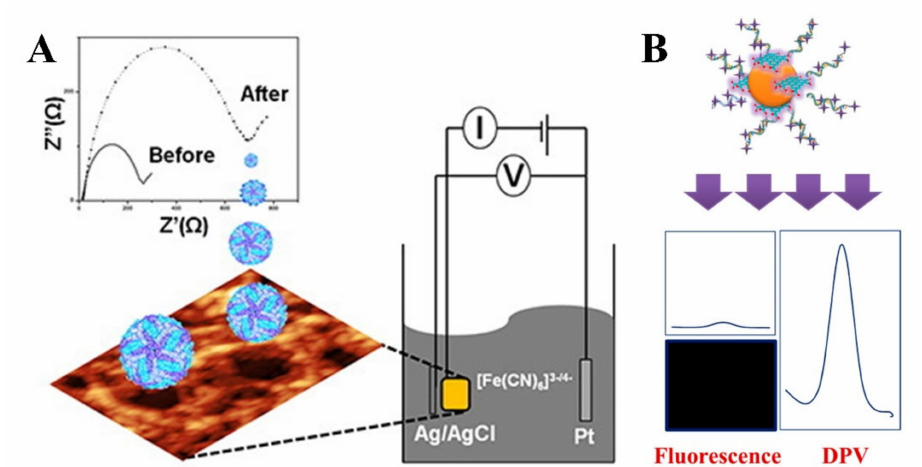
Figure 6. Electrochemical detection of DENV. ( A ) Electrochemical impedance sensing technique for DENV detection using graphene oxide and polymers (Reprinted with permission from ref. [154]. Copyright 2017 Elsevier.). ( B ) DENV virus detection using differential pulse voltammetric